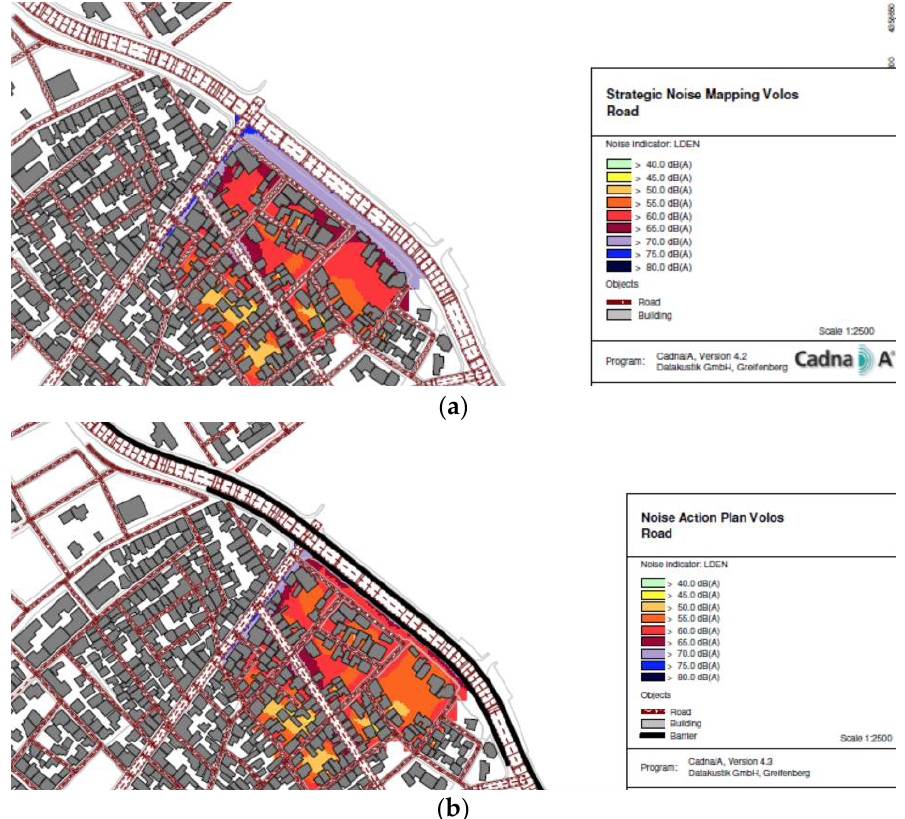
Figure 13. Sound identity map of the Iolkos UA in Volos.